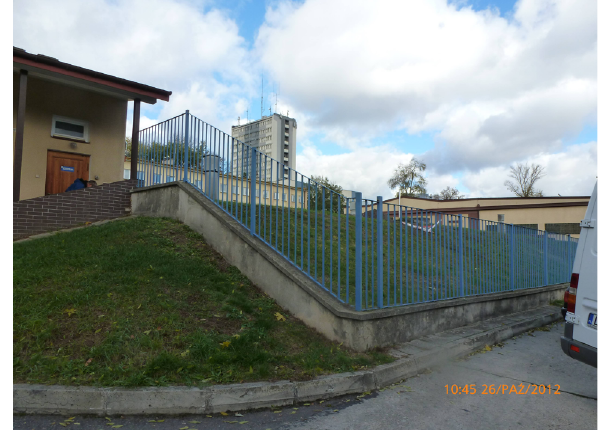
Figure 1: The outside view of water tank.